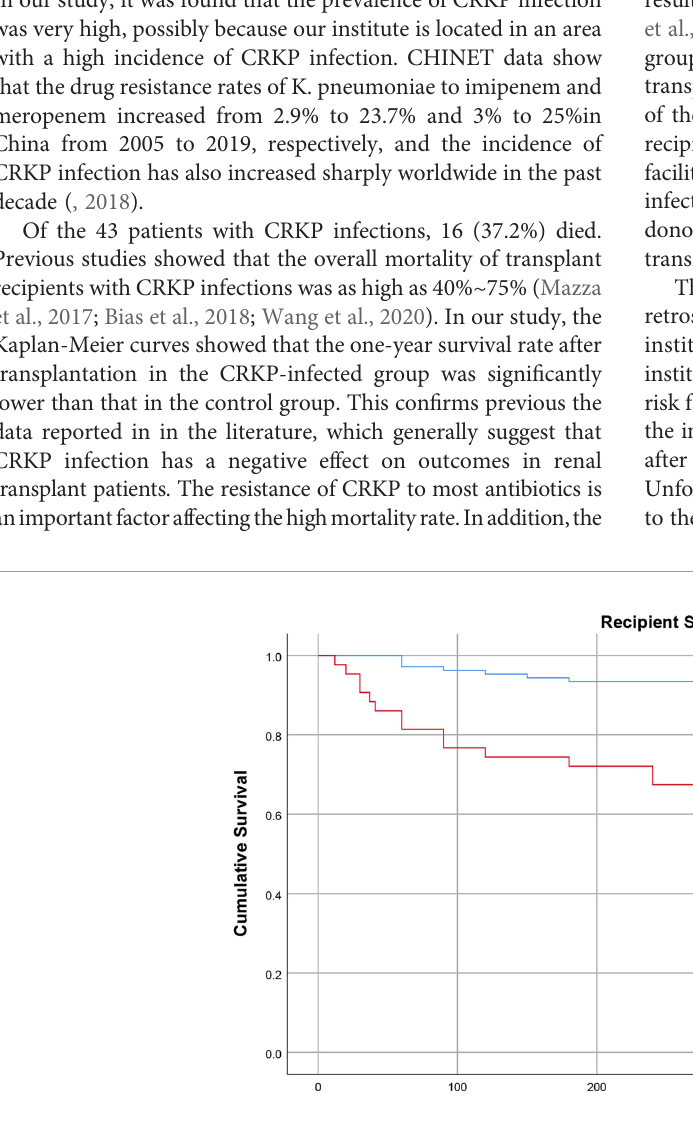
FIGURE 2 | Comparison of the one-year survival rate of infected and uninfected CRKP among early KT recipients.